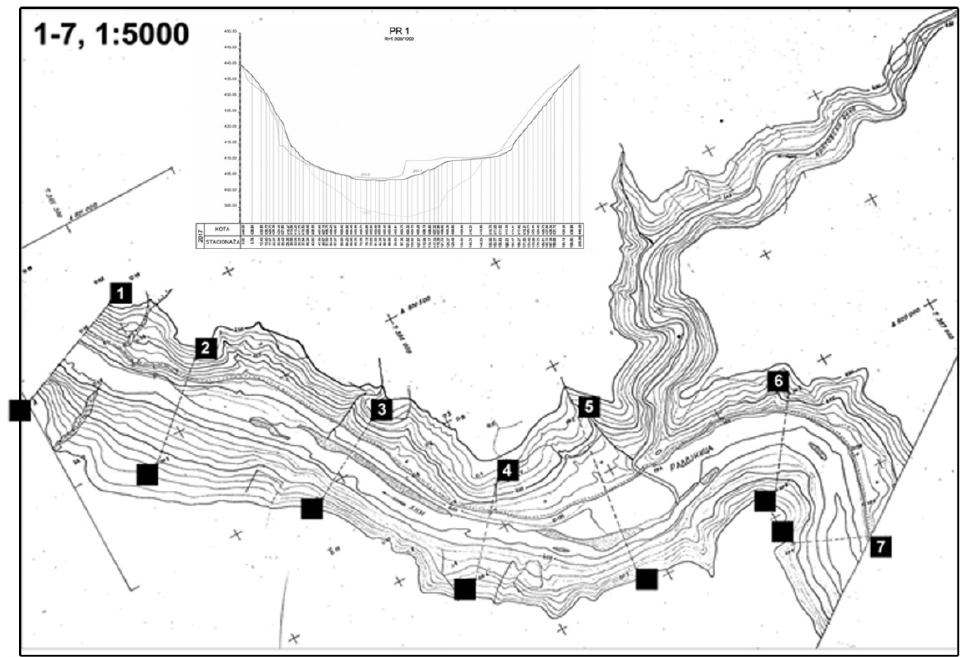
Figure 18. Bathymetric map of Potpec reservoir and representative cross-section with evidence of sediment accumulation.